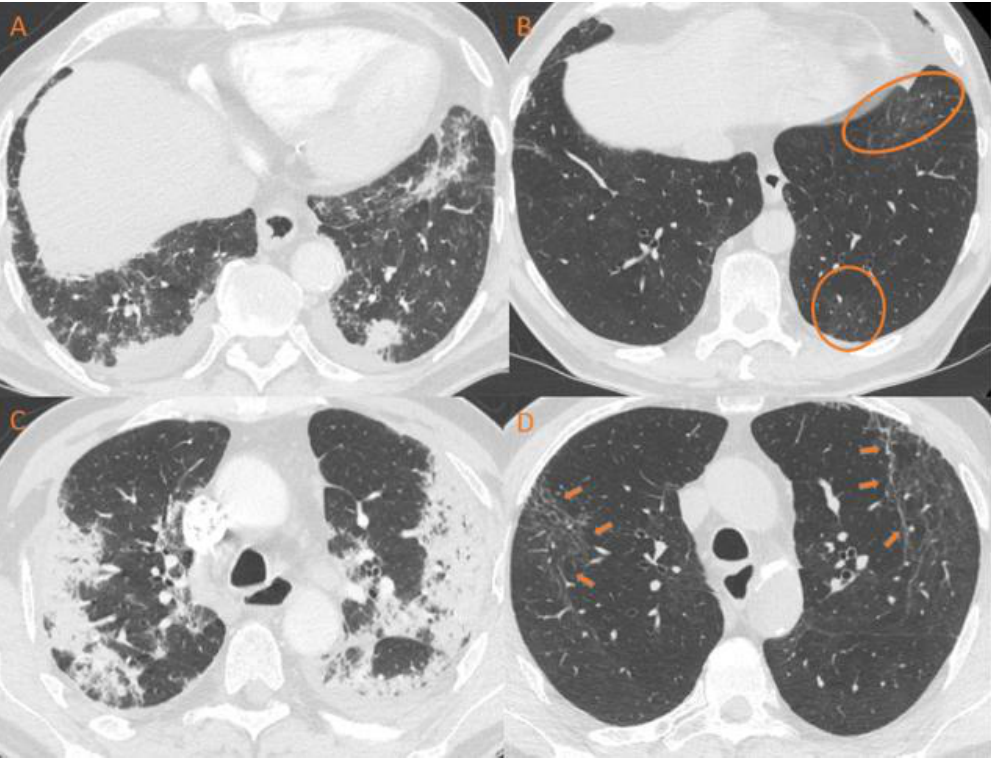
Figure 2. Example of CT-scan evolution in a 76-year-old patient. ( A , C ) acute COVID-19 phase. ( B , D ) CT-scan performed 7 months later showing persistent ground glass opacities ( B ) and retractile reticulations ( D ).